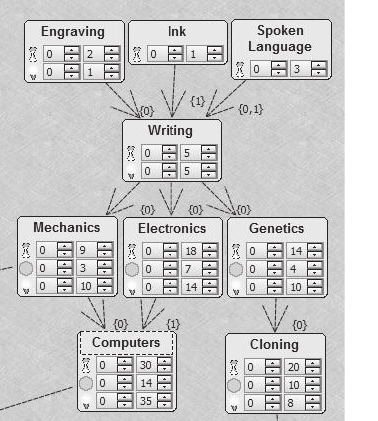
Figure 6: A modified example tech tree. A partial screen capture from TTT.